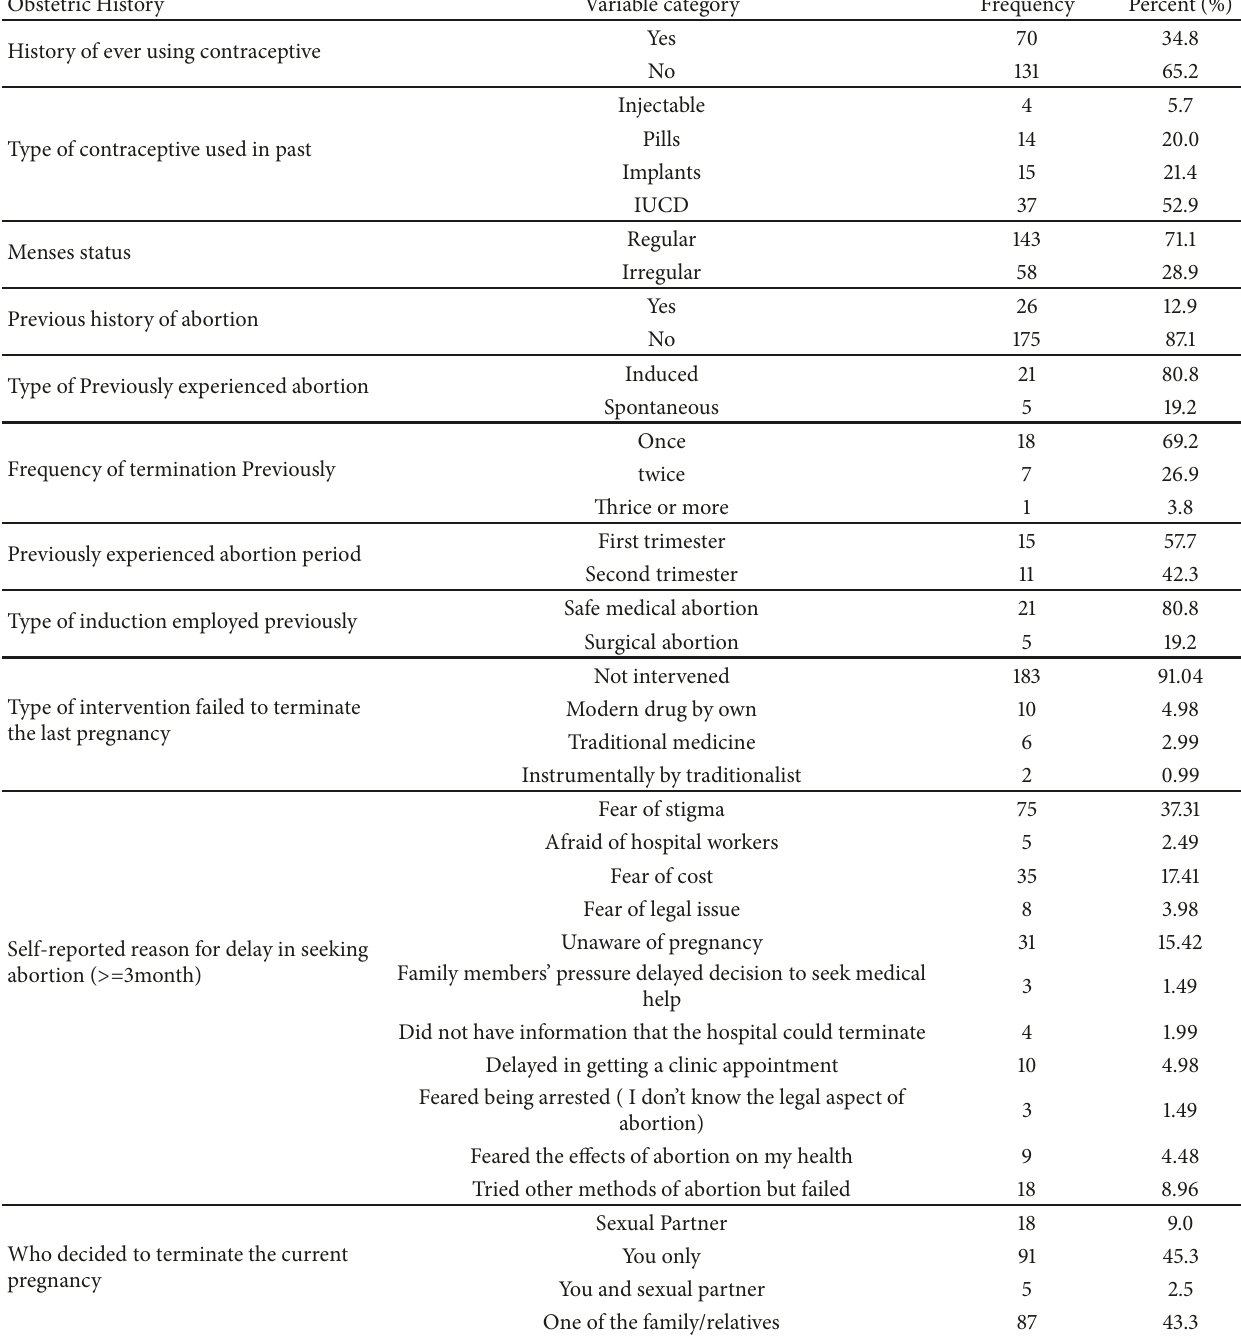
Table 2: Obstetric history of women who terminated their pregnancy using a safe medical abortion in their 2nd trimester in JUMC from November 1, 2016, to June 30,